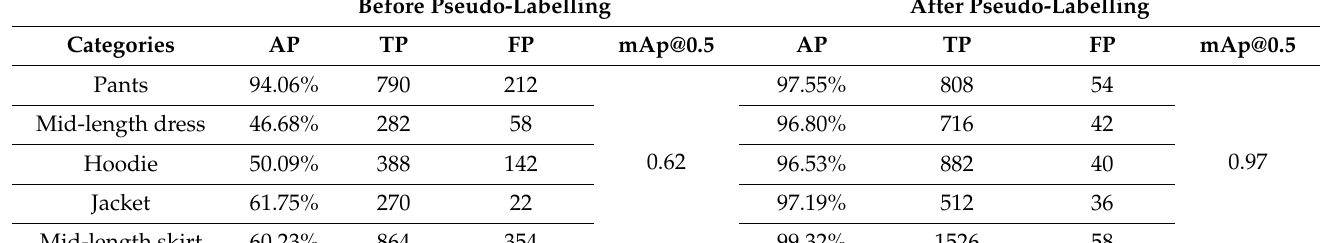
Table 6. Performance metrics on YOLOv4 before pseudo-labeling and after pseudo-labeling.